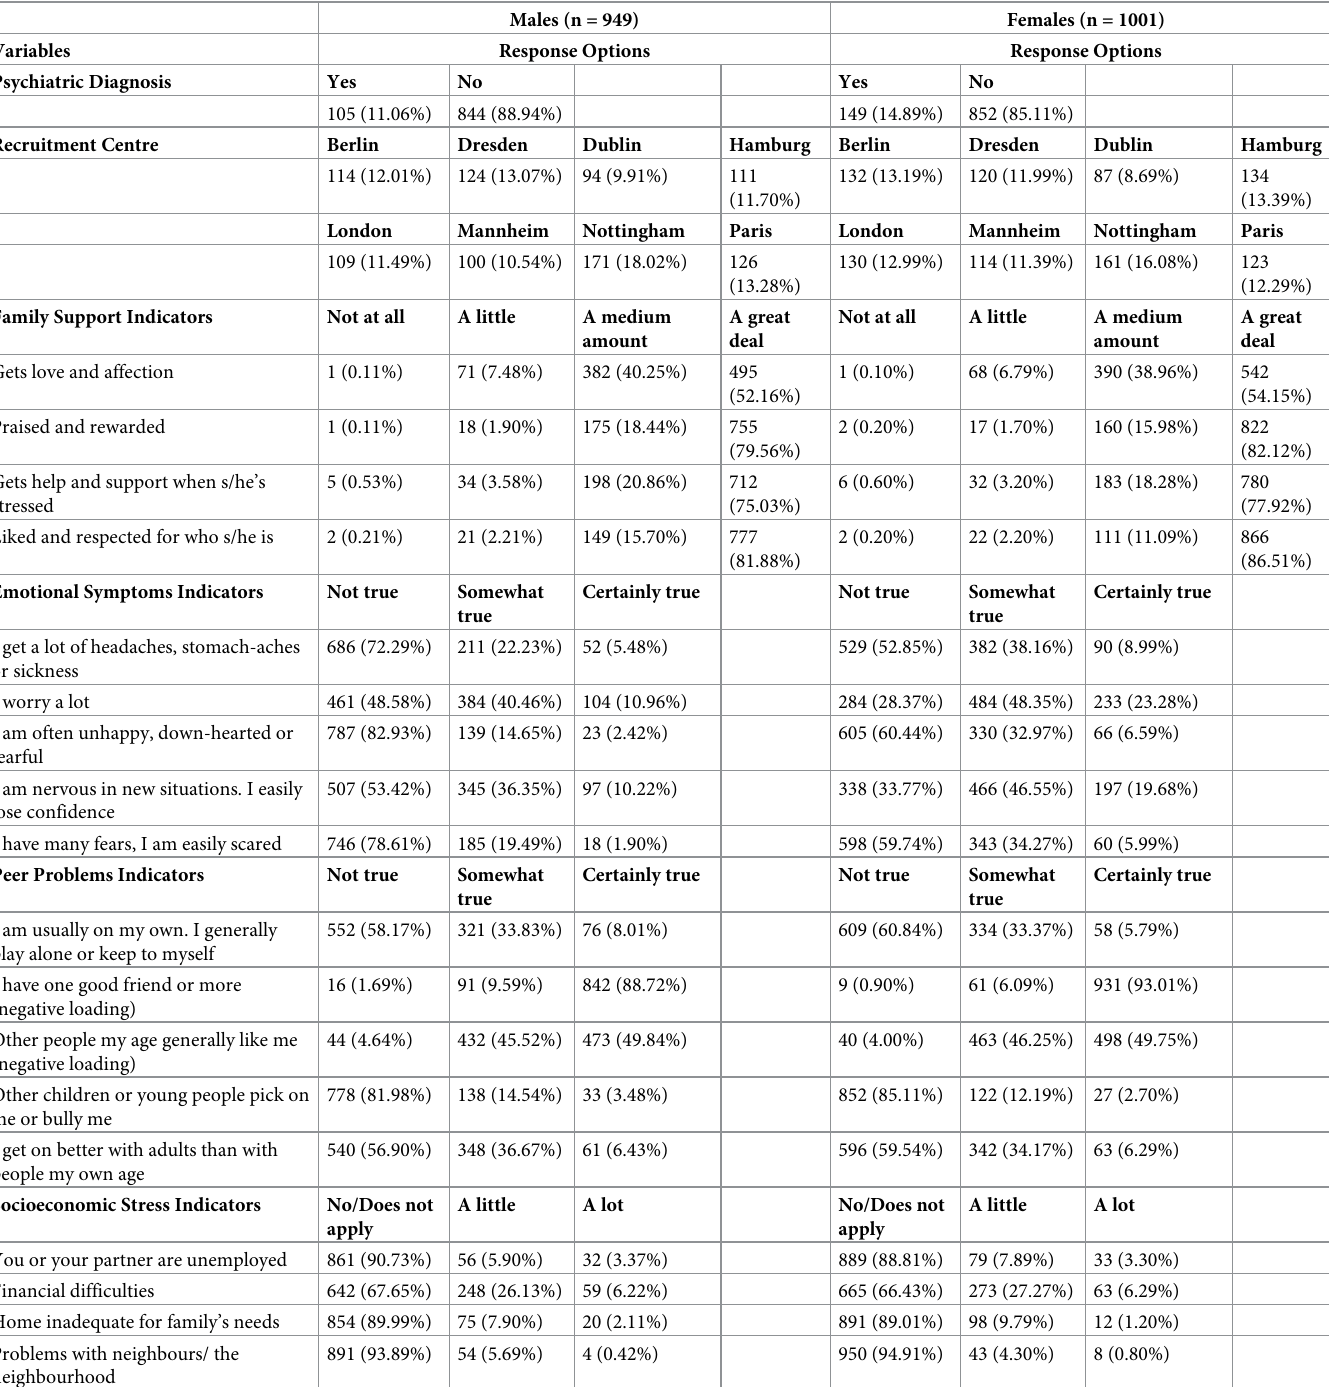
Table 3. Count data for the categorical and ordinal variables separately for males and females, expressed as both frequency and row percentage. Males (n =